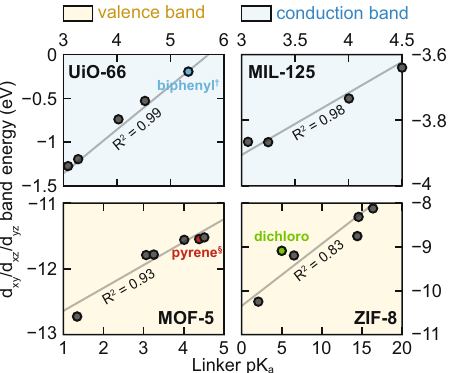
Fig. 4 The relationship between linker pKa and MOF d-orbital energy. The relationship between free-linker pK a and d -orbital extracted from the DFT computation of the bulk functionalized MOF. The d -energies are linearly related to the linker pK a with strong positive correlation. Dichloro functionality in the C 2,3 position is highlighted in green. In blue, biphenyl † is substituted for the aromatic portion of bdc (i.e., biphenyldicarboxylate) and this MOF is also known as UiO-67. In red, pyrene § is substituted for the aromatic portion of bdc (i.e., pyrenedicarboxylate) and this MOF is also known as IRMOF-14 36 . The gradients are 0.49 (UiO-66), 0.38 (MOF-5), 0.16 (MIL-125), and 0.13 (ZIF-8) eV/pK a . Bands that show up in the conduction band (d 0 MOFs) are labeled with a blue background, while those that appear within the valence band (d 10 MOFs) are labeled with a yellow background.